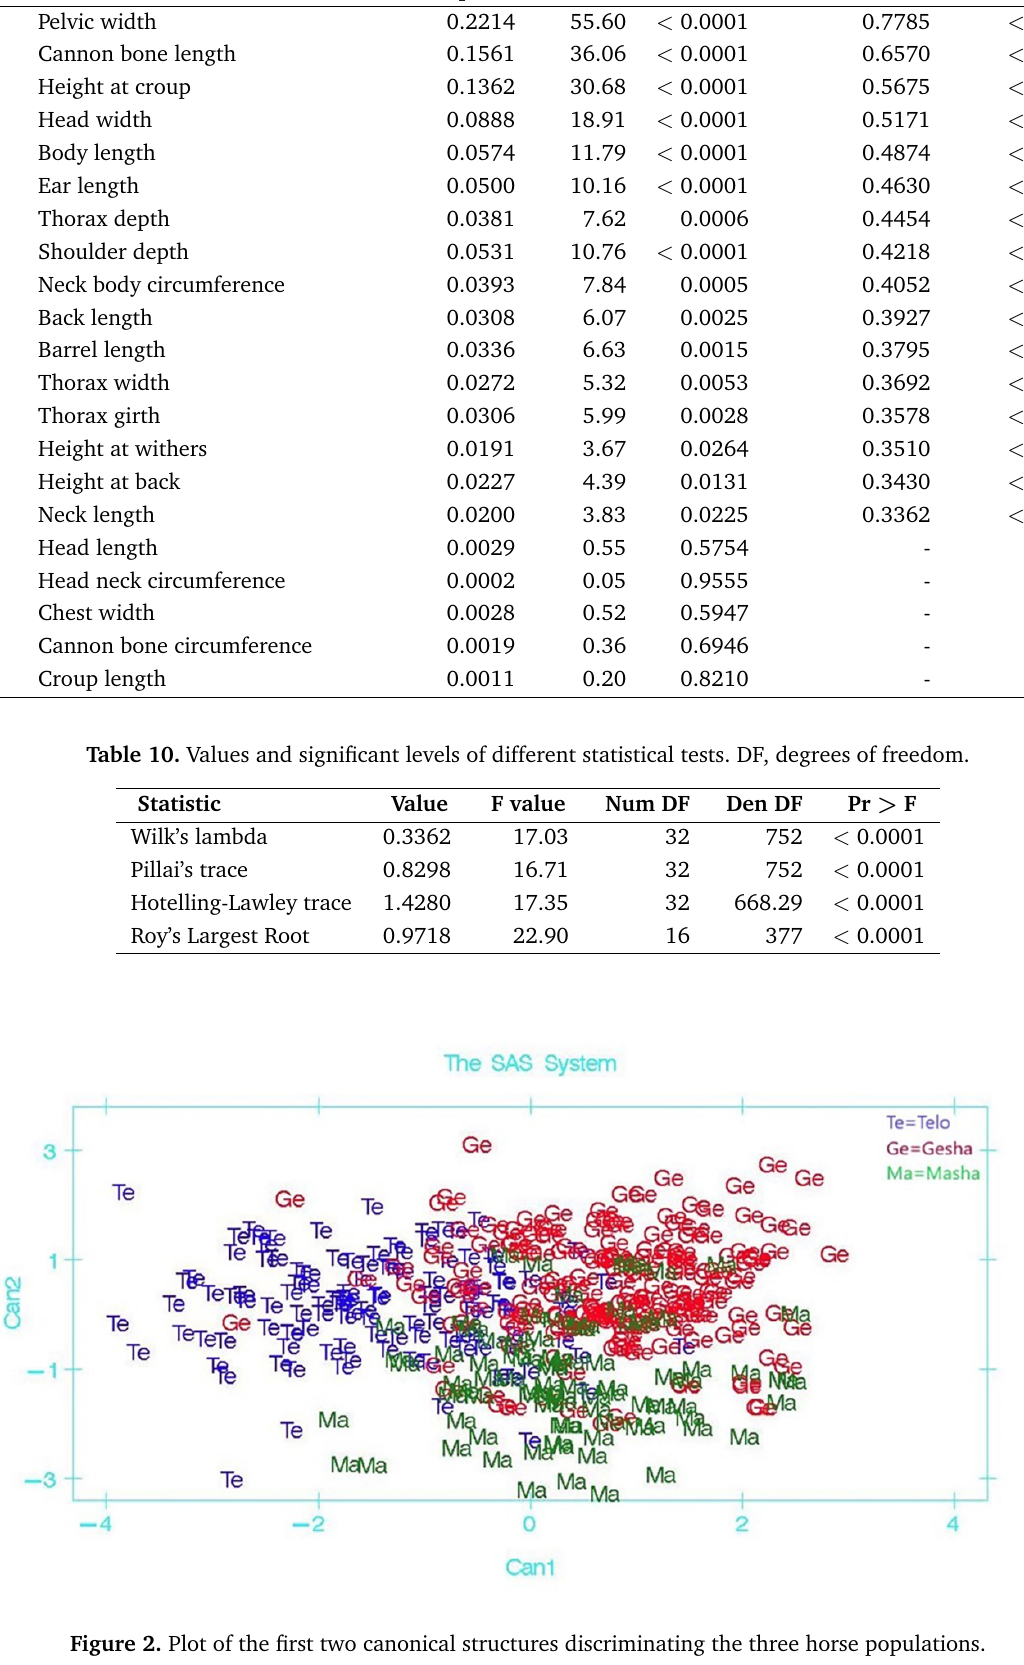
Figure 2. Plot of the first two canonical structures discriminating the three horse